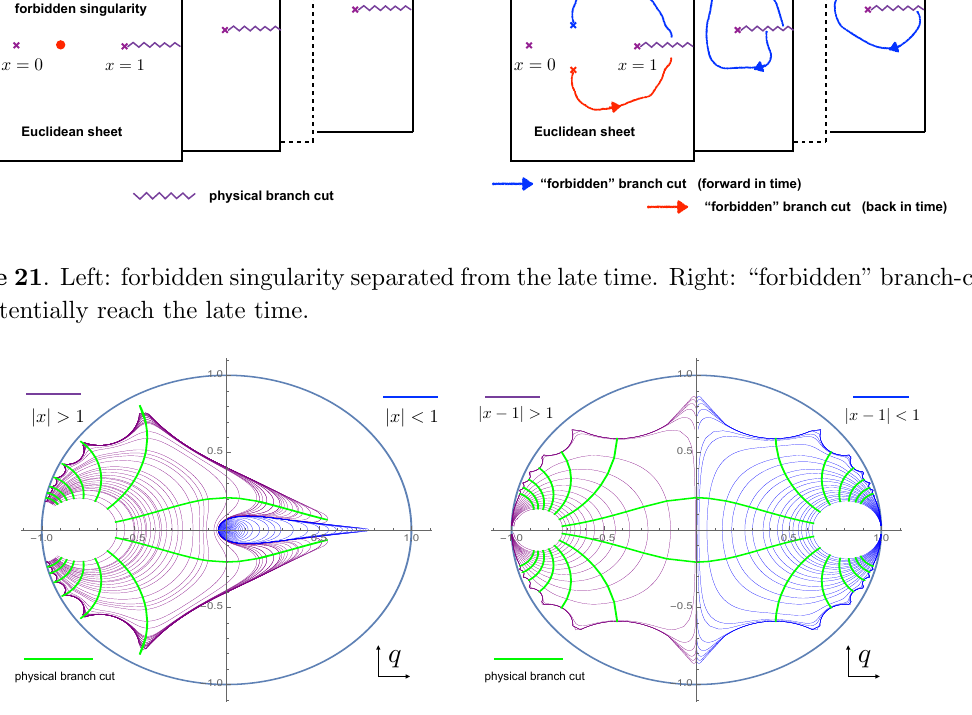
x 1 circles on the q plane. j (cid:0) j in the original x -plane, 1